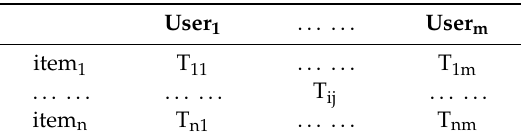
Table 4. Score time